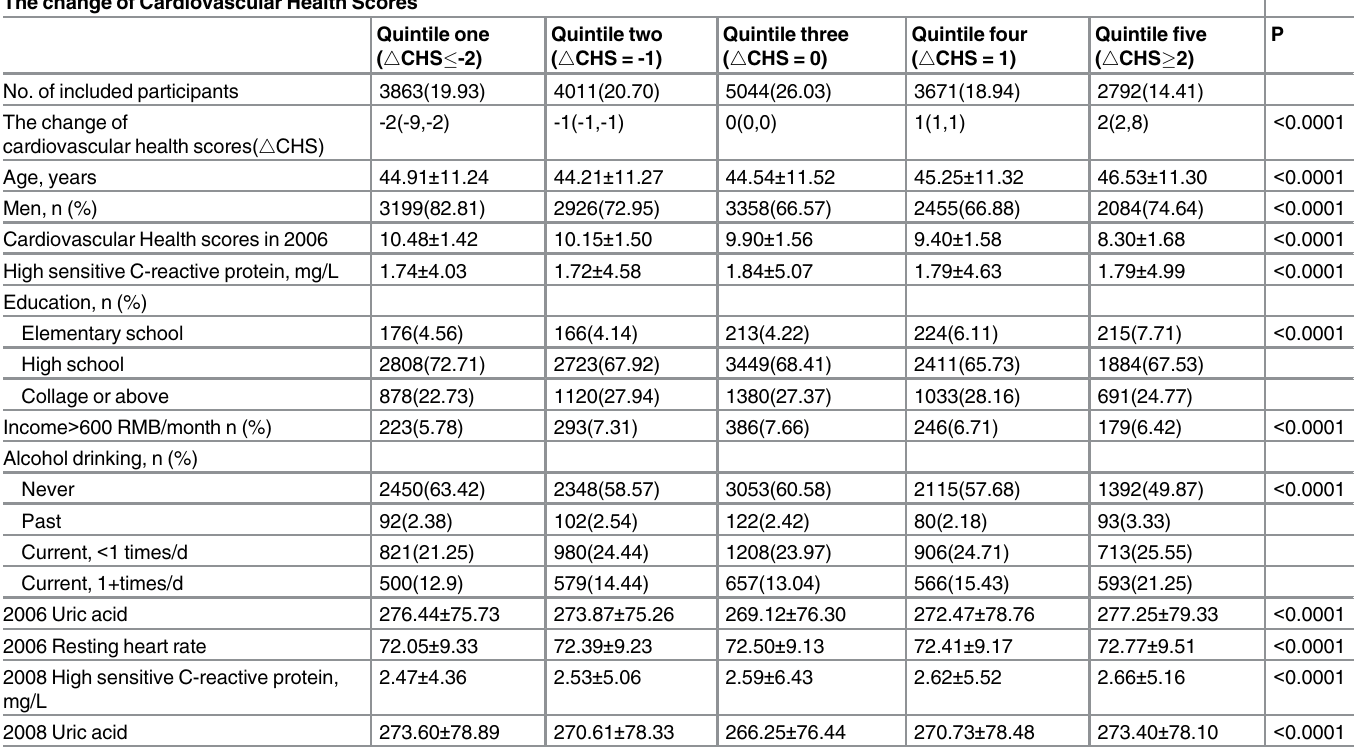
Table 1. Basic Characteristics in 2006 according to the change of cardiovascular health scores ( 4 CHS) from 2006 to 2008.